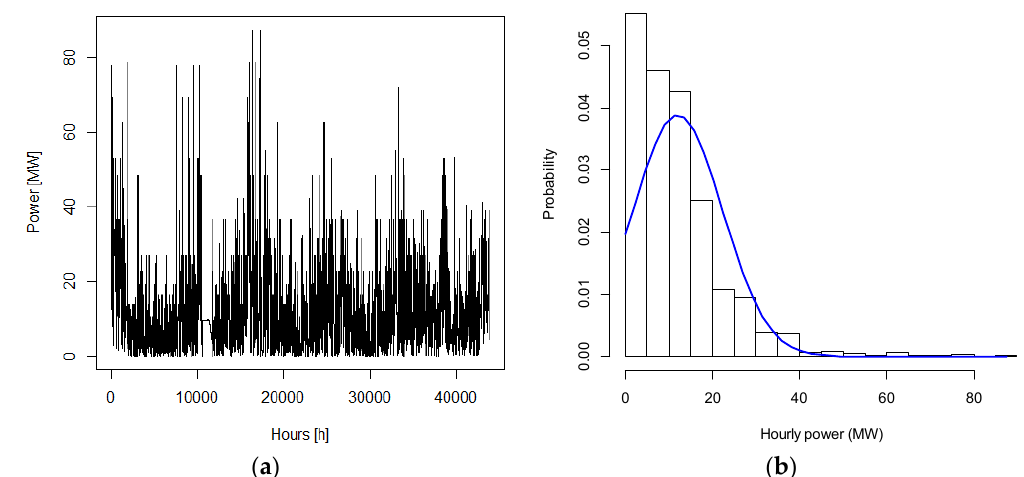
Figure 6. Generated power by wind ‐ wave farm: ( a ) Temporal evolution; and ( b ) Histogram and probabilistic distribution function (pdf).